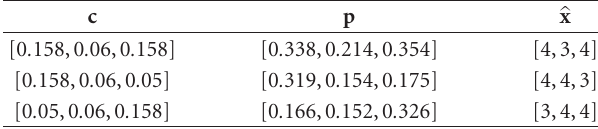
Table 1: Results of minimum-energy path configuration.